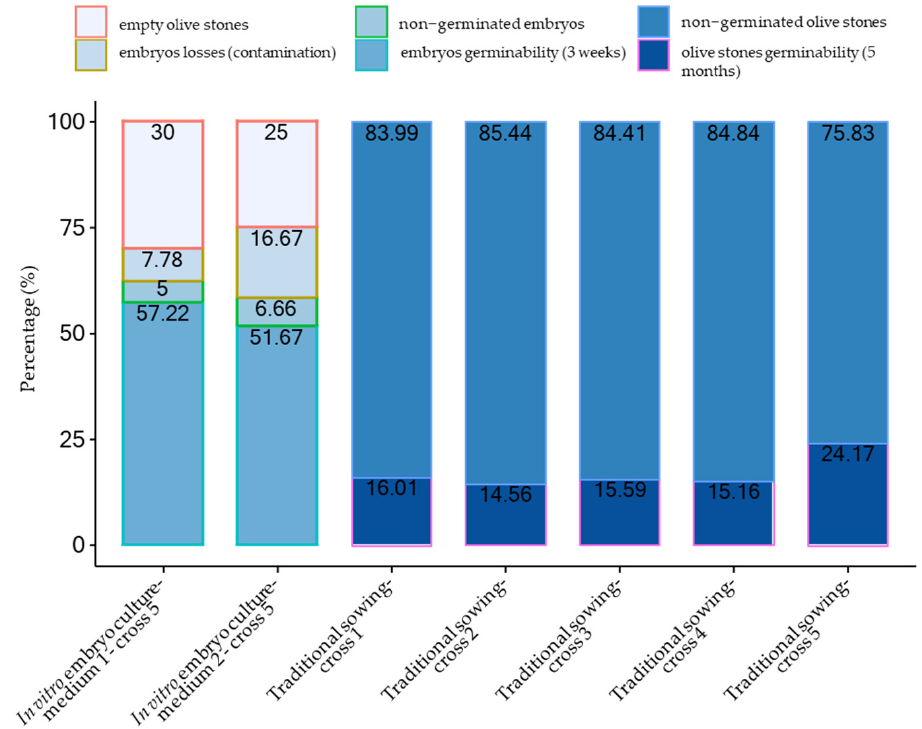
Figure 2. Germination percentages of in vitro isolated olive embryos on the two media tested compared to the germinability of directly sown olive stones from the 5 different cross combinations of the 2017 season.